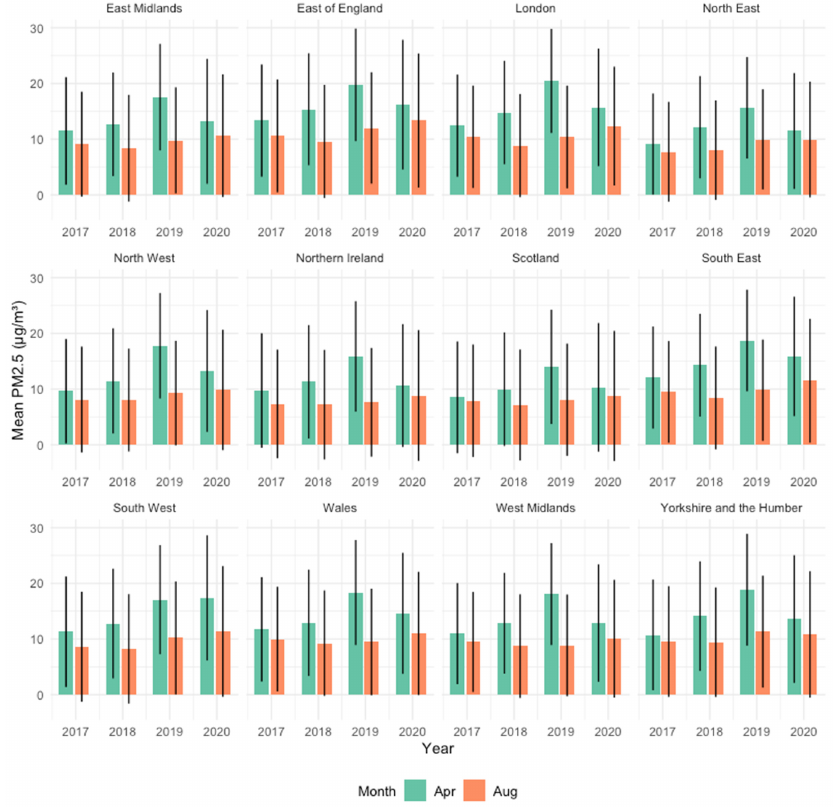
Figure 2. Mean PM 2.5 exposure by region in each month. Error bars represent standard deviation. There were no significant differences in modelled exposure by other demographic characteristics, including ethnicity, gender and NS ‐ SEC occupation code.